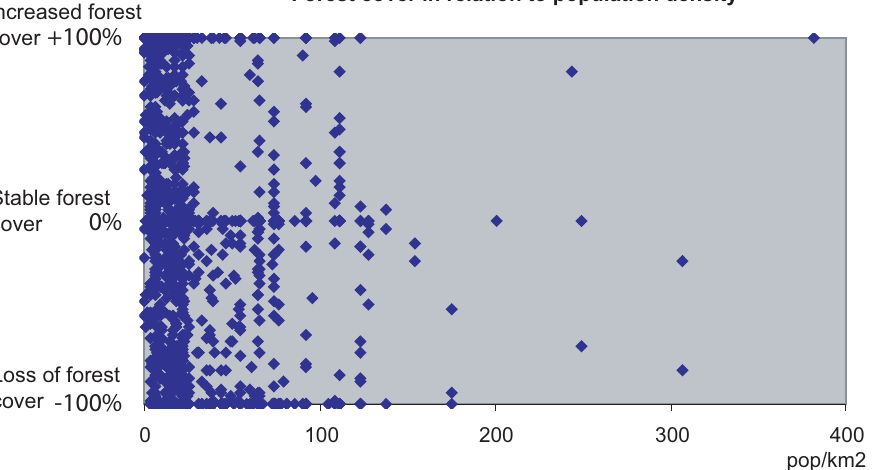
Figure 8. The relationship between forest cover change (%) during 1984–2000 in Androy, and human population density Population censuses based on LandScan 2001 Global Population Database (Oakridge, TN: Oak Ridge National Laboratory http://www.ornl.gov/gist/). The analysis was based on 1 km 2 plots (n=564) throughout the area covered with forest either in 1984 or 2000.